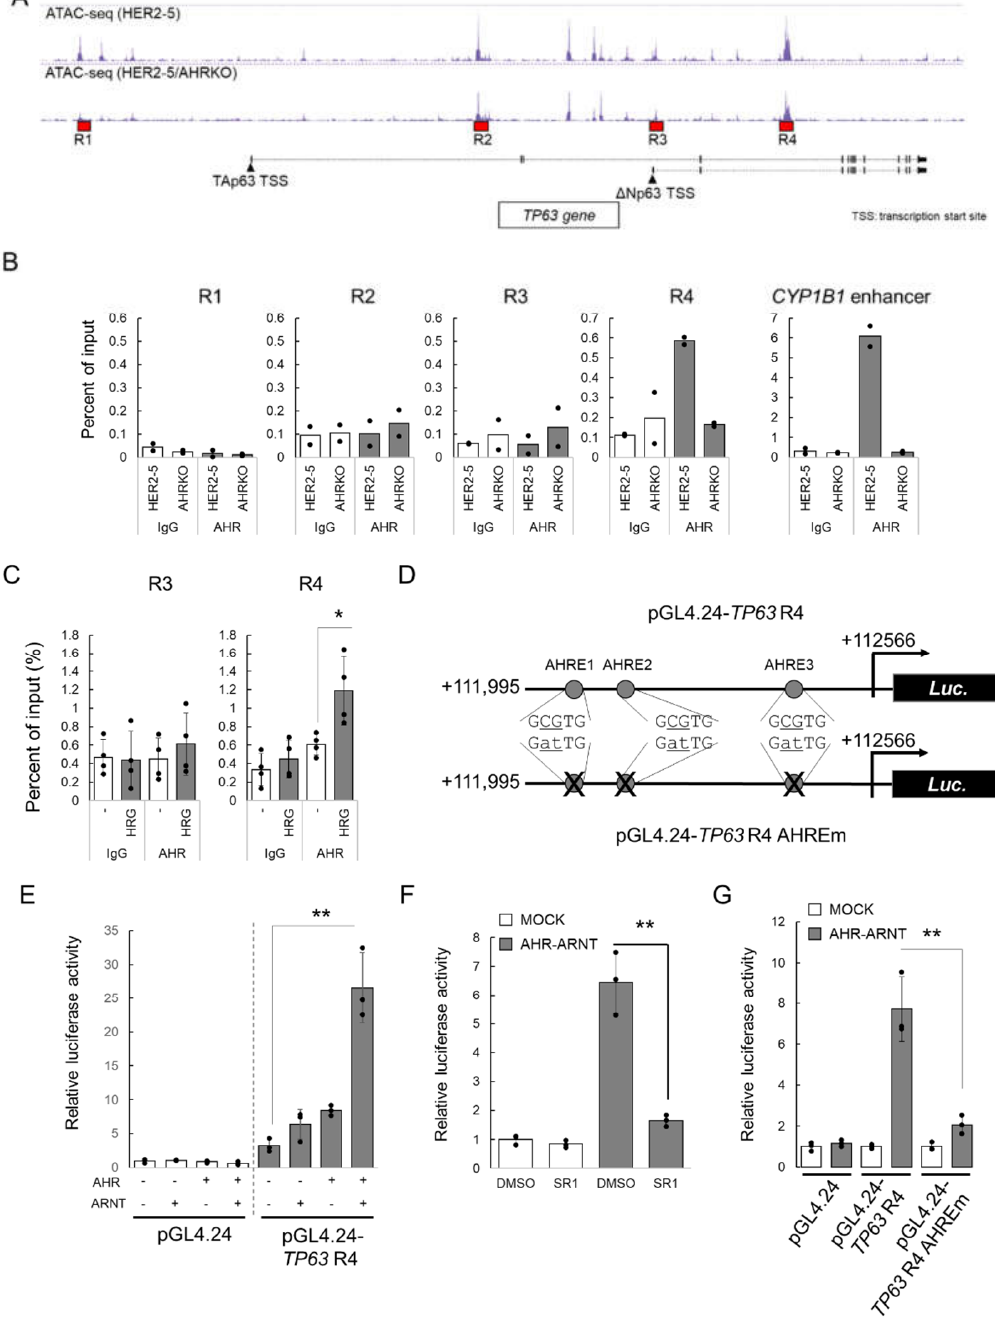
Figure 4. Binding of HRG-activated AHR to the enhancer region of TP63 . ( A ) ATAC-seq tracks (HER2-5 and HER2-5/AHRKO cells) around TP63 are shown. R1, R2, R3, and R4 regions were investigated by performing a chromatin immunoprecipitation (ChIP) assay. ( B ) HER2-5 and HER2- 5/AHRKO cells were subjected to ChIP assays with anti-AHR and control IgGs. The AHR bound to DNA was quantified by qPCR with primers specific for R1, R2, R3, and R4, as well as the CYP1B1 enhancer region. The bars represent the mean percentage of the input control of two independent experiments, and all data are expressed as closed cycles. ( C ) HER2-5 cells were cultured under low serum conditions (DMEM containing 2% charcoal-stripped fetal bovine serum, csFBS) for 24 h and treated with HRG (50 ng/mL) or vehicle (water) for 3 h. The cells were subjected to ChIP assays with anti-AHR and control IgGs. The amount of AHR bound to DNA was quantified by qPCR with primers specific for R3 and R4. The bars represent the mean percentage of the input control of four independent experiments and are expressed as the mean ± S.D. (n = 4). *, p < 0.05 (Student’s t test). ( D ) Schematic illustration of pGL4.24-TP63 R4 and pGL4.24-TP63 R4 AHREm plasmids. Putative (circle, GCGTG) and mutated AHREs (GatTG) are indicated. ( E ) HER2-5/AHRKO cells were co-